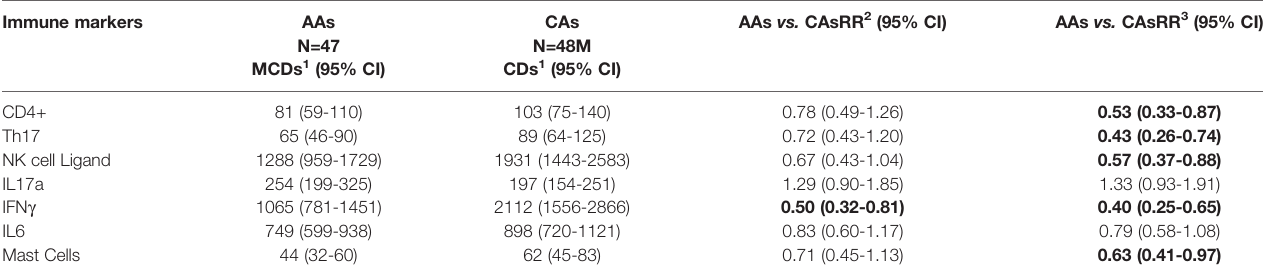
TABLE 2 | Mean density counts (MDC) and density rate ratios (RR) in African American (AA) and Caucasian American (CA) tumor immune markers. Immune markers